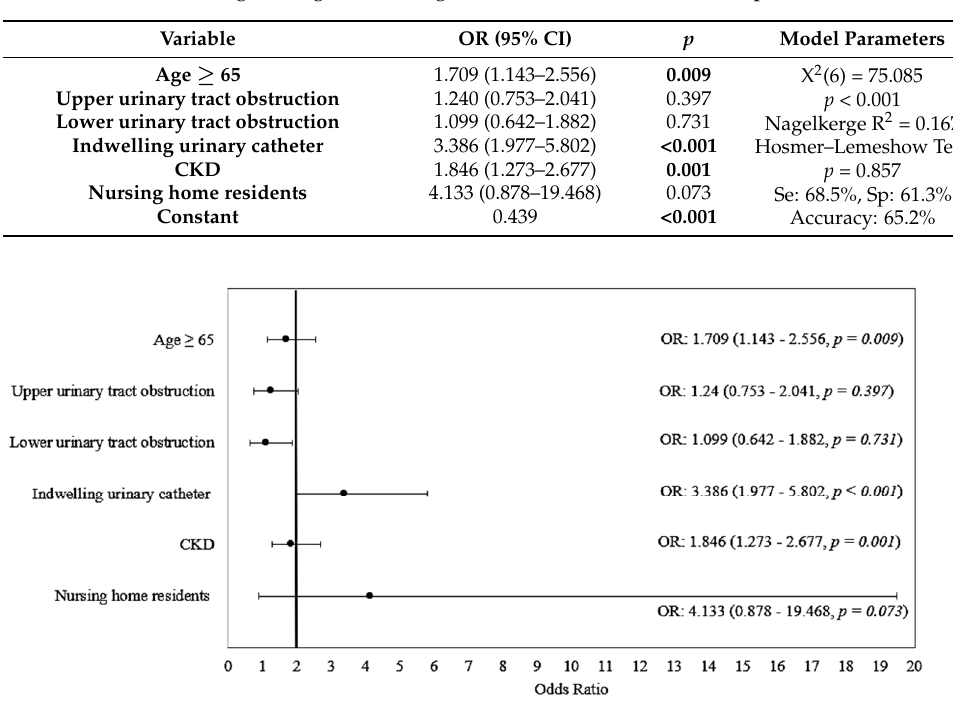
Figure 2. Forest plot for odds ratio with 95% confidence intervals multivariate analysis of risk factors for general antibiotic resistance.